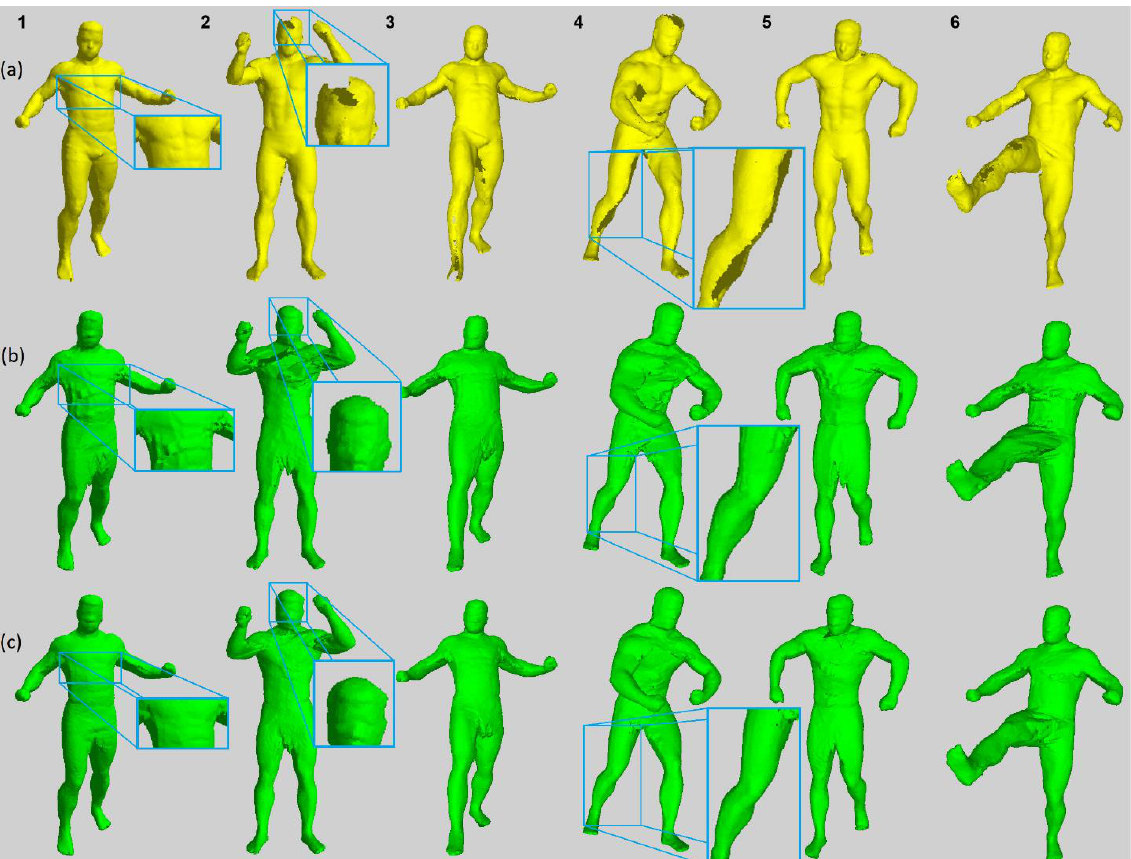
Figure 7. Surface reconstruction results comparison for selected dataset samples; every column ID number corresponds to a data sample from Table A1: ( a ) SfM; ( b ) SfS; ( c ) sSfS.